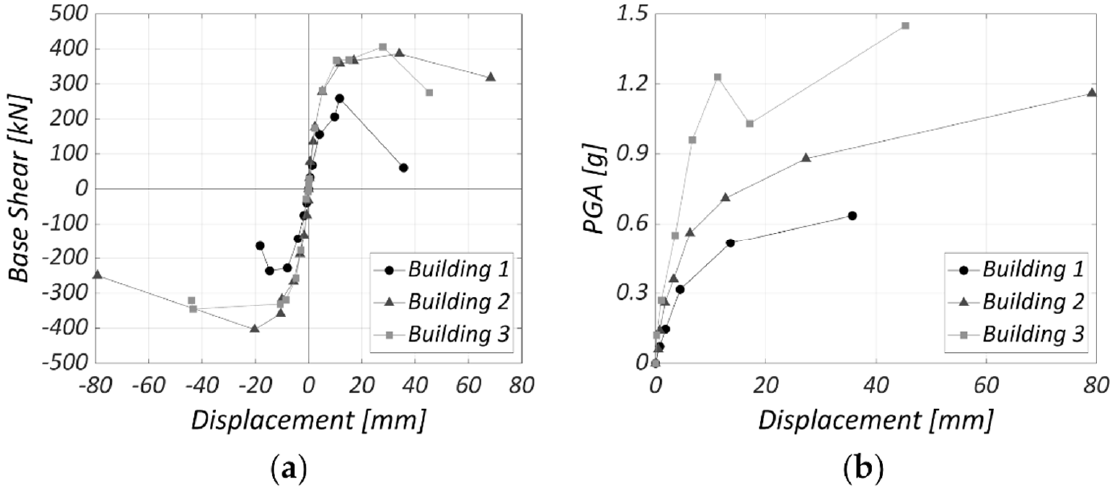
Figure 10. Shake-table test results: ( a ) backbone curves; ( b ) incremental dynamic test (IDT) curves.